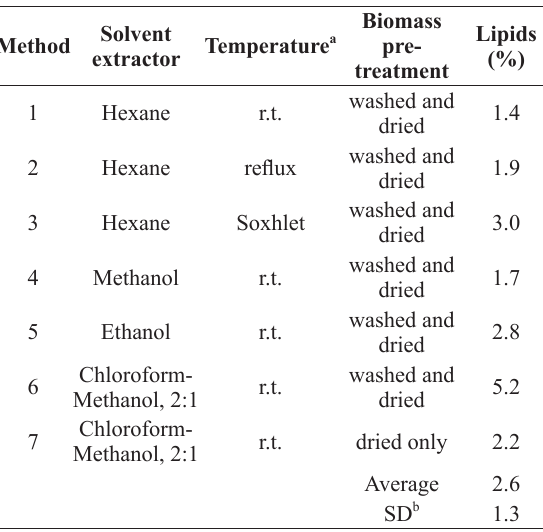
Percentage of total lipids of Sarcocornia ambigua fertile shoot meal extracted with different